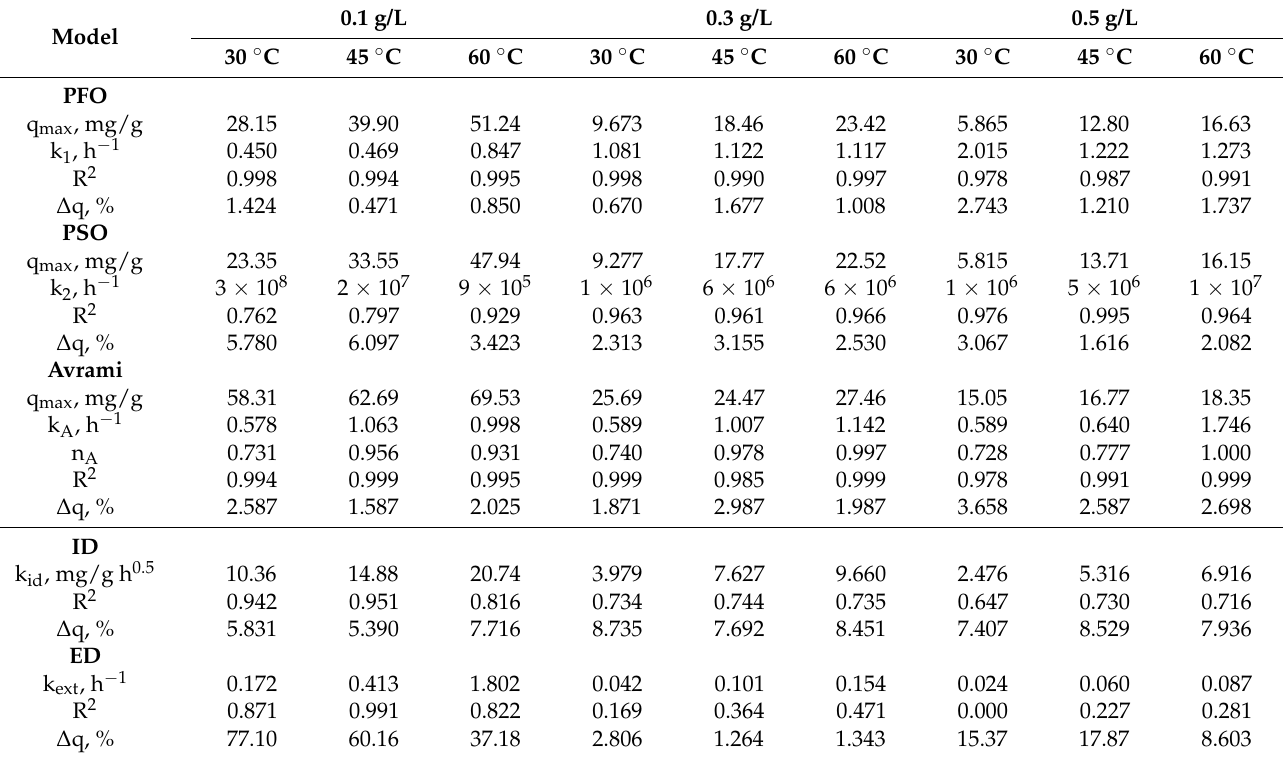
Table 7. Kinetic parameters for PR adsorption with